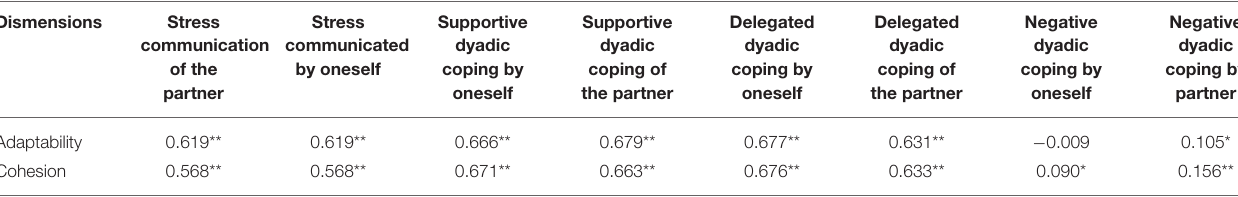
TABLE 3 | Correlation between dyadic coping and family adaptability and cohesion.